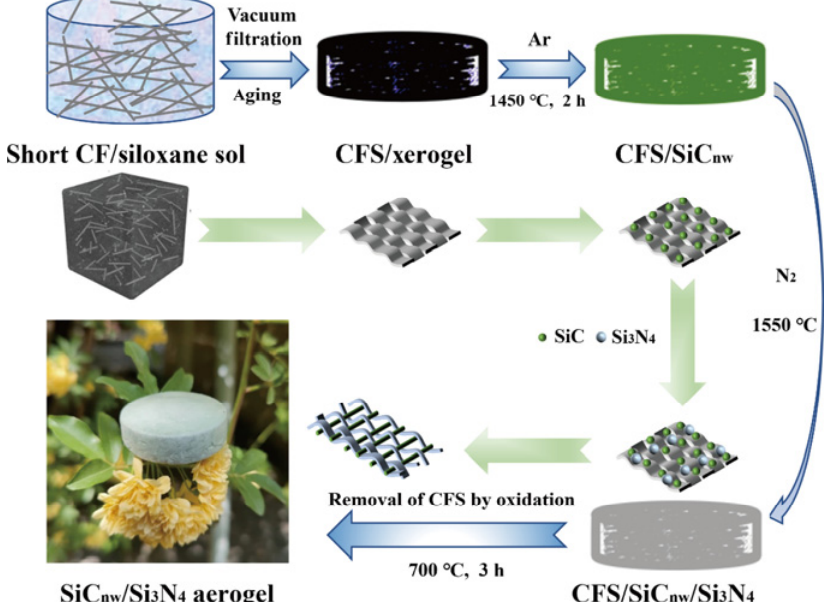
Fig. 1 Schematic diagram of manufacturing process of the SiC/Si 3 N 4 composite